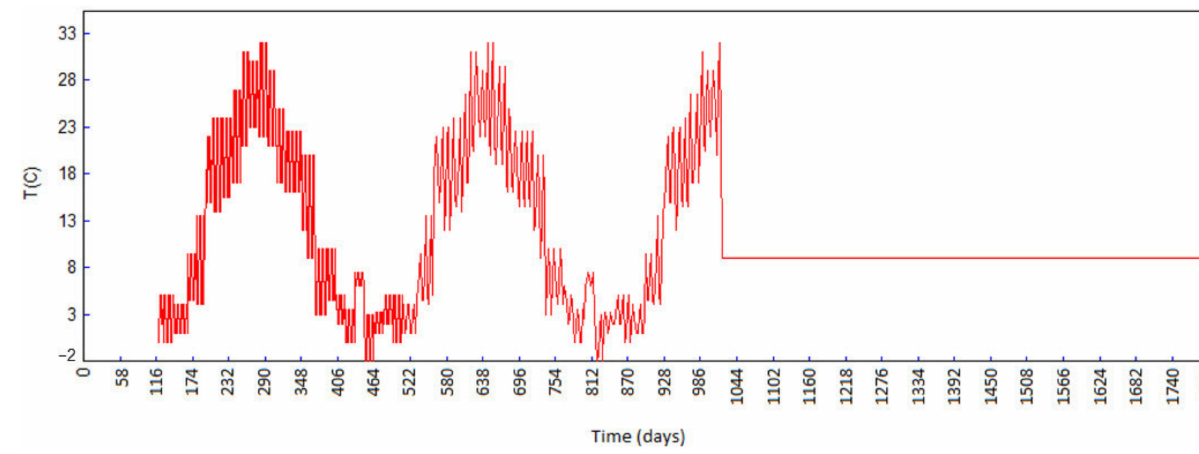
Figure 9. Concrete temperature ( ◦ C) in node 2787 (upstream